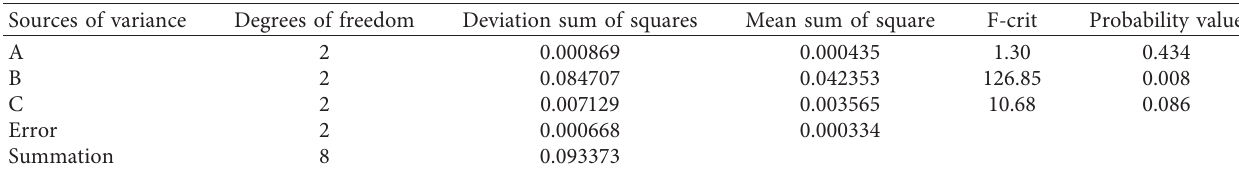
Table 8: Analysis of